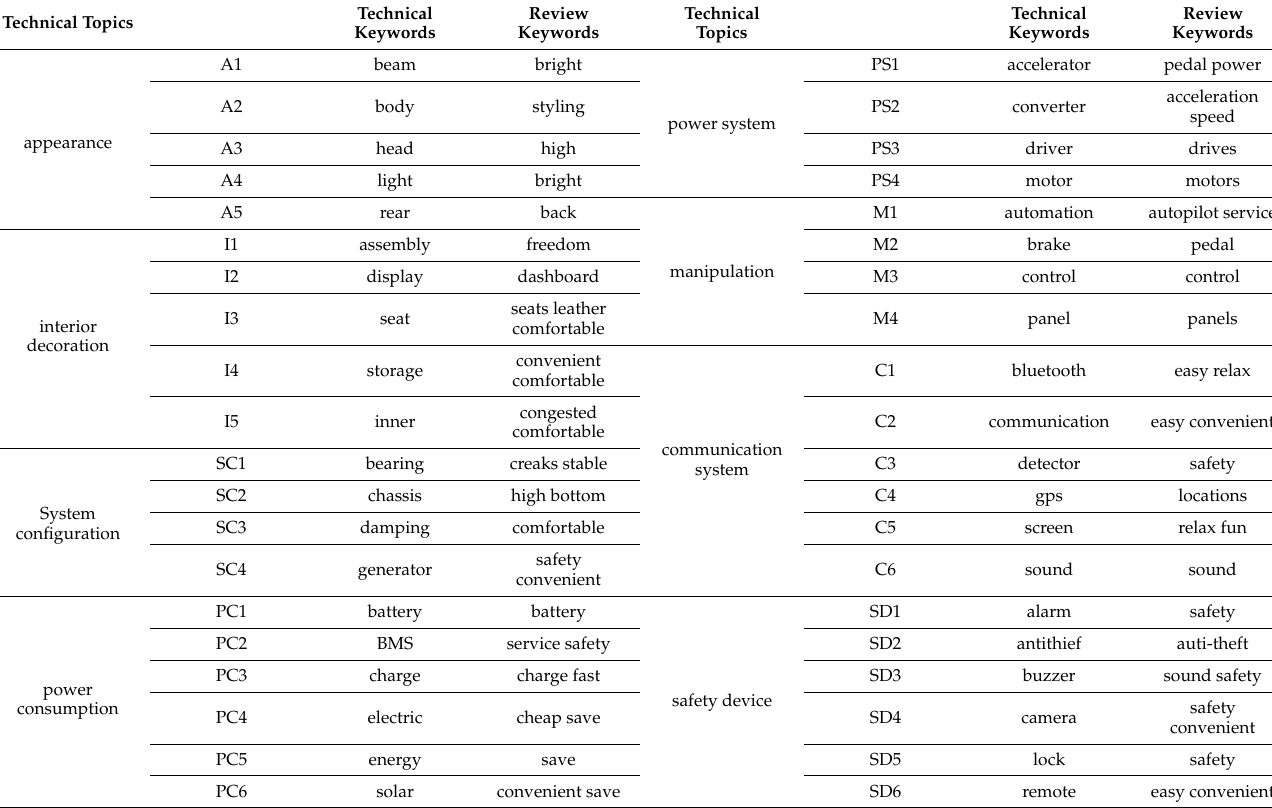
Table 3. Technical topics classification of review and technical keywords in the EVs